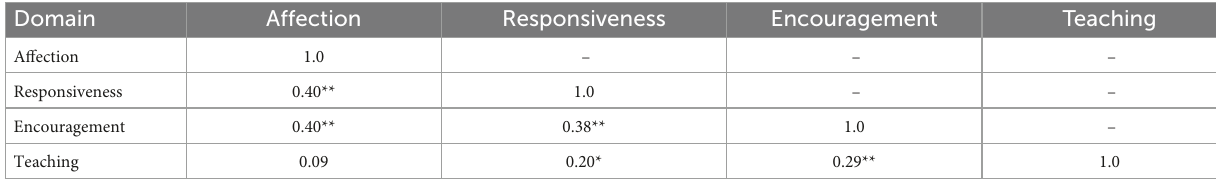
TABLE 1 Pearson’s correlation coefficients among Italian Parenting Interactions with Children: Checklist of Observations Linked to Outcomes (PICCOLO) domains ( N = 152). Domain